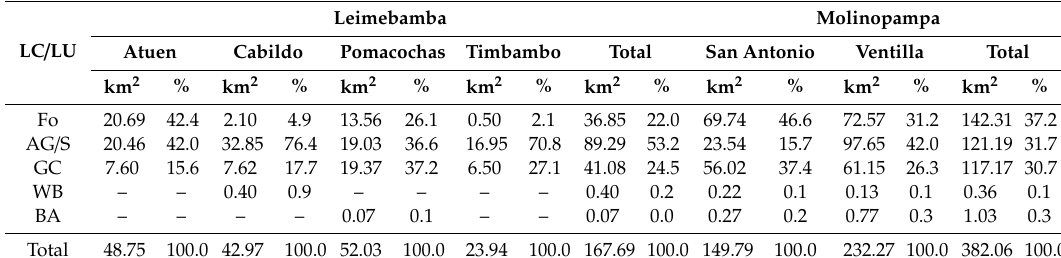
Table 11. Land Cover / Land Use (LC / LU) of the four HAL-MWs in Leimebamba and two HAL-MWs in Molinopampa (Amazonas, Peru). Leimebamba Molinopampa LC / LU Atuen Cabildo Pomacochas Timbambo Total San